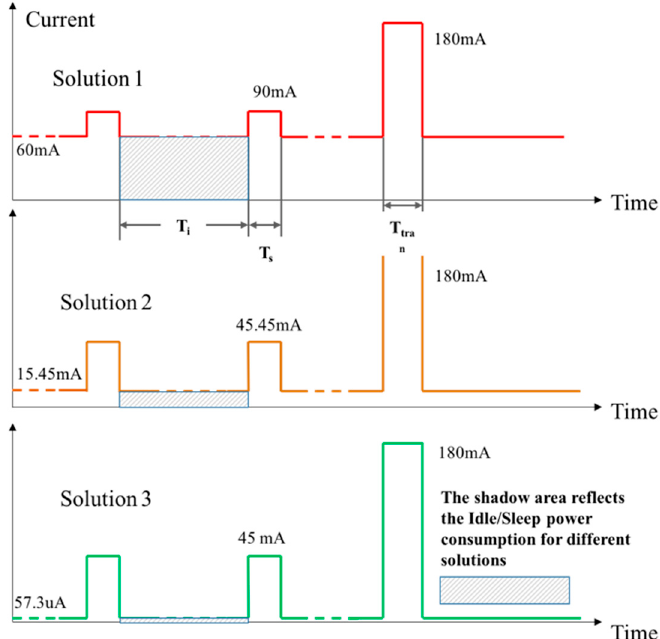
Figure 10. Energy consumption illustrations resulting from the three solutions.